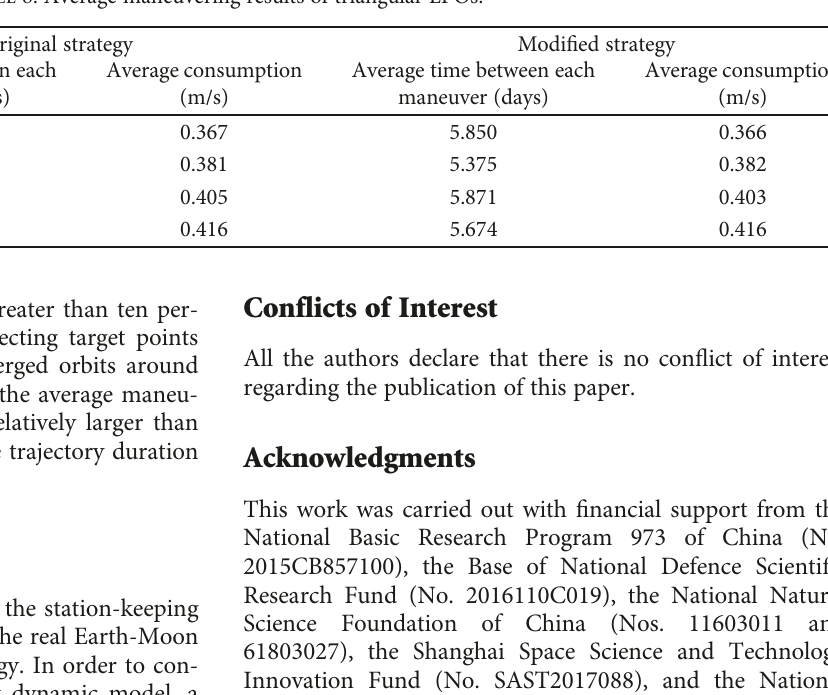
Table 8: Average maneuvering results of triangular